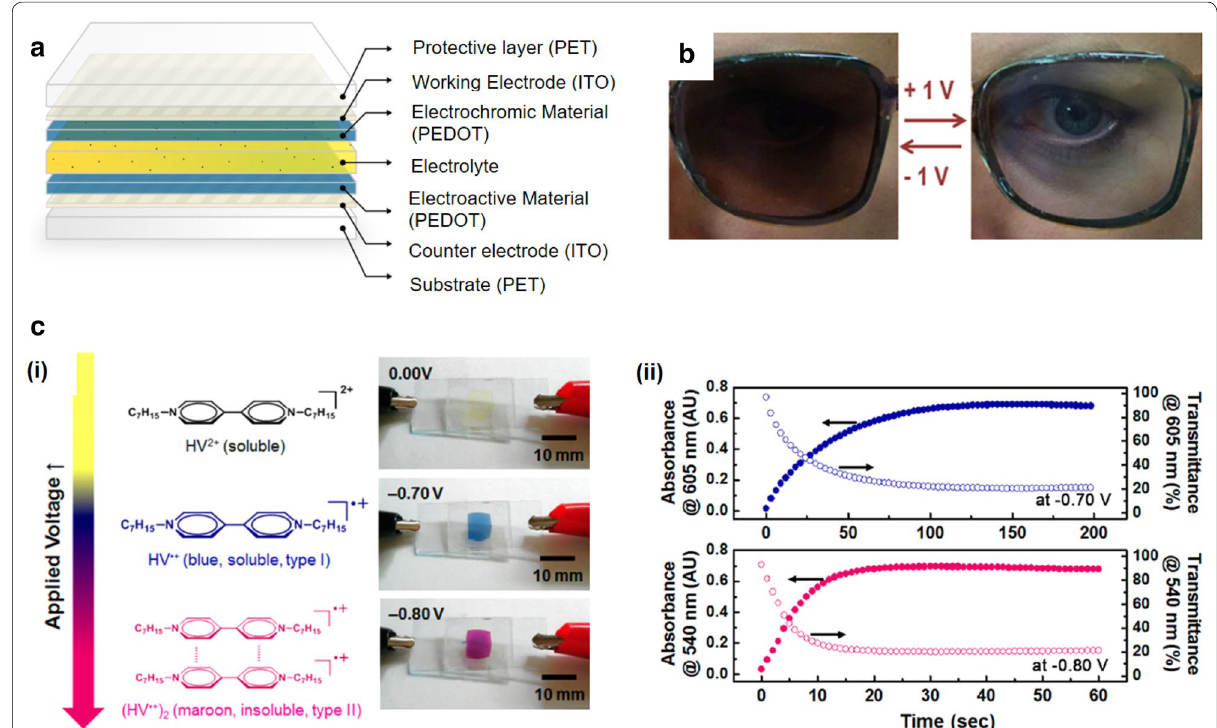
Fig. 4 Technologies for electrochromic displays. a Assembly configuration of an electrochromic display and material for each part. b Photographs of an electrochromic glasses at 1.0 V and 1.0 V with brown blend of orange and periwinkle. c (i) Photographs for three different states of an − + electrochromic gel: bleached at 0.00 V, blue